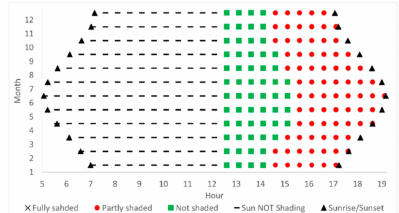
Figure 12. State of shading: east-facing surface, latitude 32 ◦ N, D = 20 m, H = 10 m, L = 40 m.